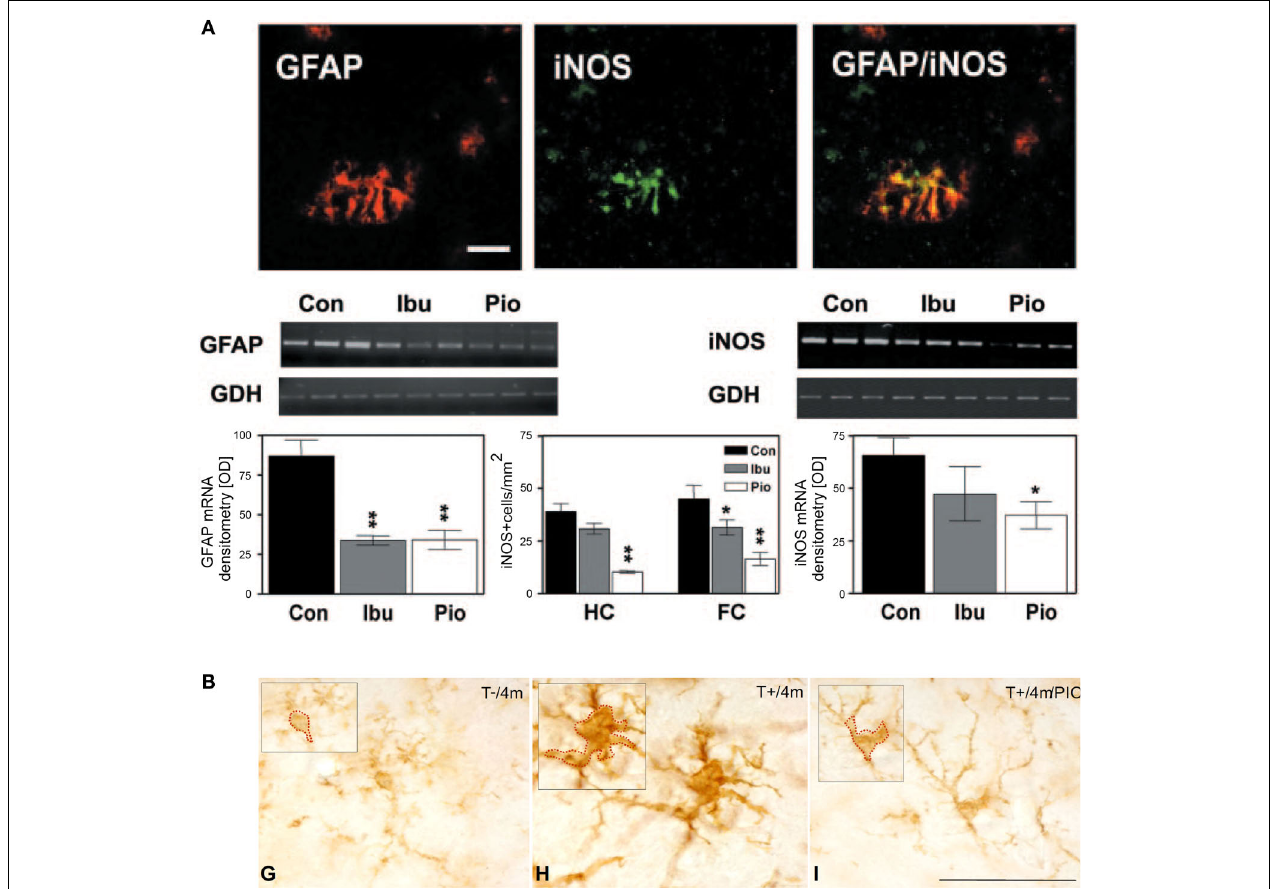
et al. (2005) and Elsevier. (B) Pioglitazone countered microglial activation in TGF mice (T + ) relative to age-matched controls (T − ), as seen by the shrinking of the cell soma in animals treated for 2 months starting at 2 months of age. Bar, 50 µm. Reproduced with permission from Lacombe et al. (2004) and